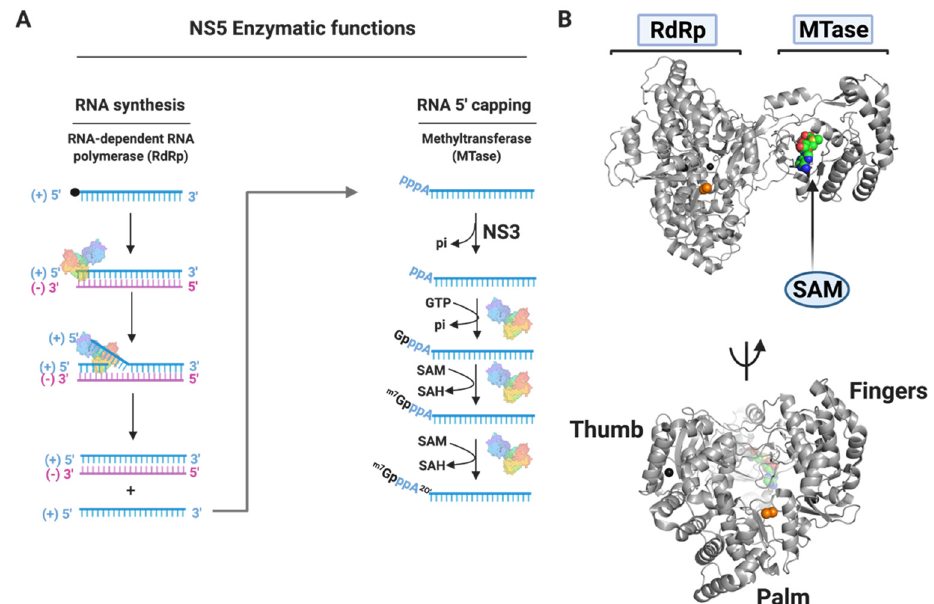
Figure 3. The Enzymatic Functions of Dengue NS5. NS5 plays a major role in the flaviviral replication complex including RNA synthesis, RNA capping, and RNA methylation. The exact sequence of events is not yet fully understood, but a general scheme ( A ) is widely accepted. The (+) strand genomic RNA is used by the NS5 RdRp as a template to synthesize a ( − ) strand RNA which results in a replicative dsRNA intermediate. The ( − ) strand of the dsRNA intermediate then serves as a template for (+) strand synthesis, after which the dsRNA product is released and used for additional synthesis of (+) strands. Newly synthesized (+) strands are capped and methylated to form (+) strands of genomic RNA. The 5 (cid:48) -RNA capping begins with the triphosphatase activity of the NS3 helicase, where the terminal phosphate at the 5 (cid:48) -end of the (+) strand RNA is removed leading to a diphosphorylated RNA. The NS5 methyltransferase (MTase) caps the RNA through its guanylyl-transferase activity, where guanine monophosphate (GMP) is transferred to the 5 (cid:48) -end of the diphosphorylated (+) strand RNA from GTP. The capped RNA is methylated by the NS5 MTase via two sequential methylations: an initial methylation at the N7 position of the guanine cap, and a subsequent methylation at the 2 (cid:48) O position of the first RNA nucleotide. S-adenosyl-L-methionine (SAM) is utilized as a methyl donor in both methylations and is converted to S-adenosyl-L-homocysteine (SAH) as a by-product of the reactions. A cartoon representation ( B ) of a crystal structure of the full-length dengue serotype 2 NS5 is shown with the canonical features of the NS5 RdRp. PDB ID: 5ZQK.